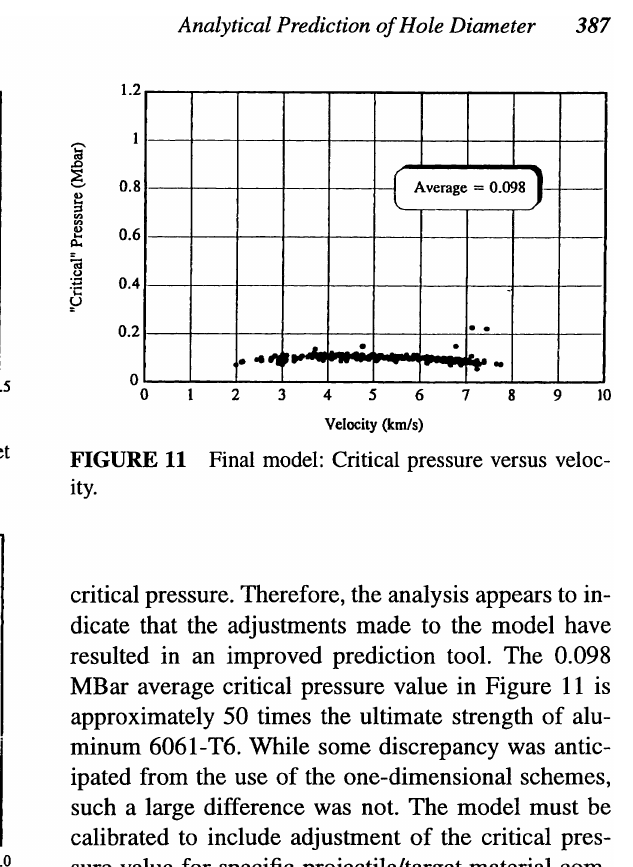
FIGURE 10 Final model: Critical pressure versus projec tile diameter.